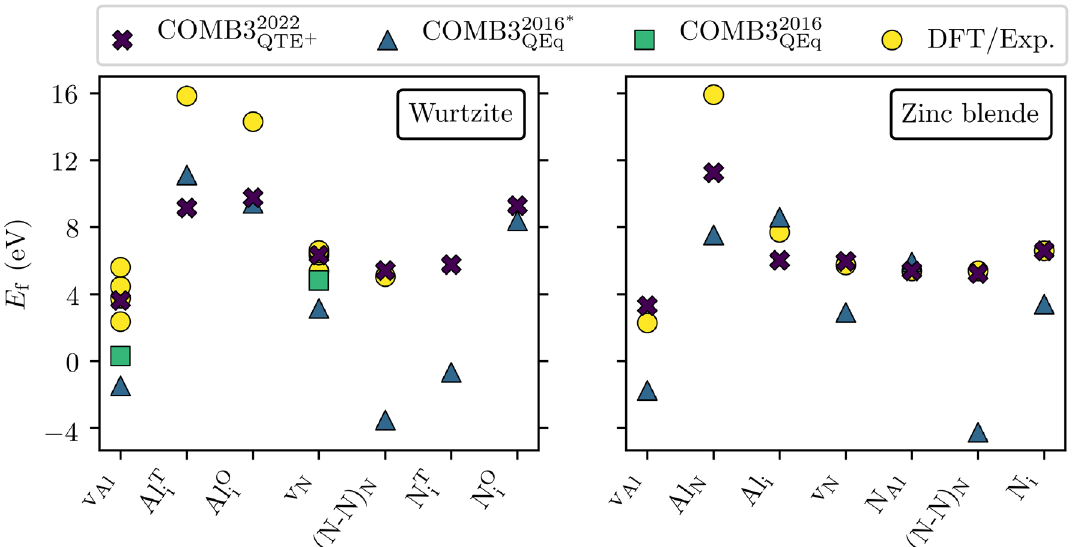
Figure 2. AlN defect formation energies obtained with COMB3 2022 COMB3 2016 QEq AlN publication, and DFT as well as experimental findings 9,43–46 . The references are broken down in the Supplementary Tables S2 and Table